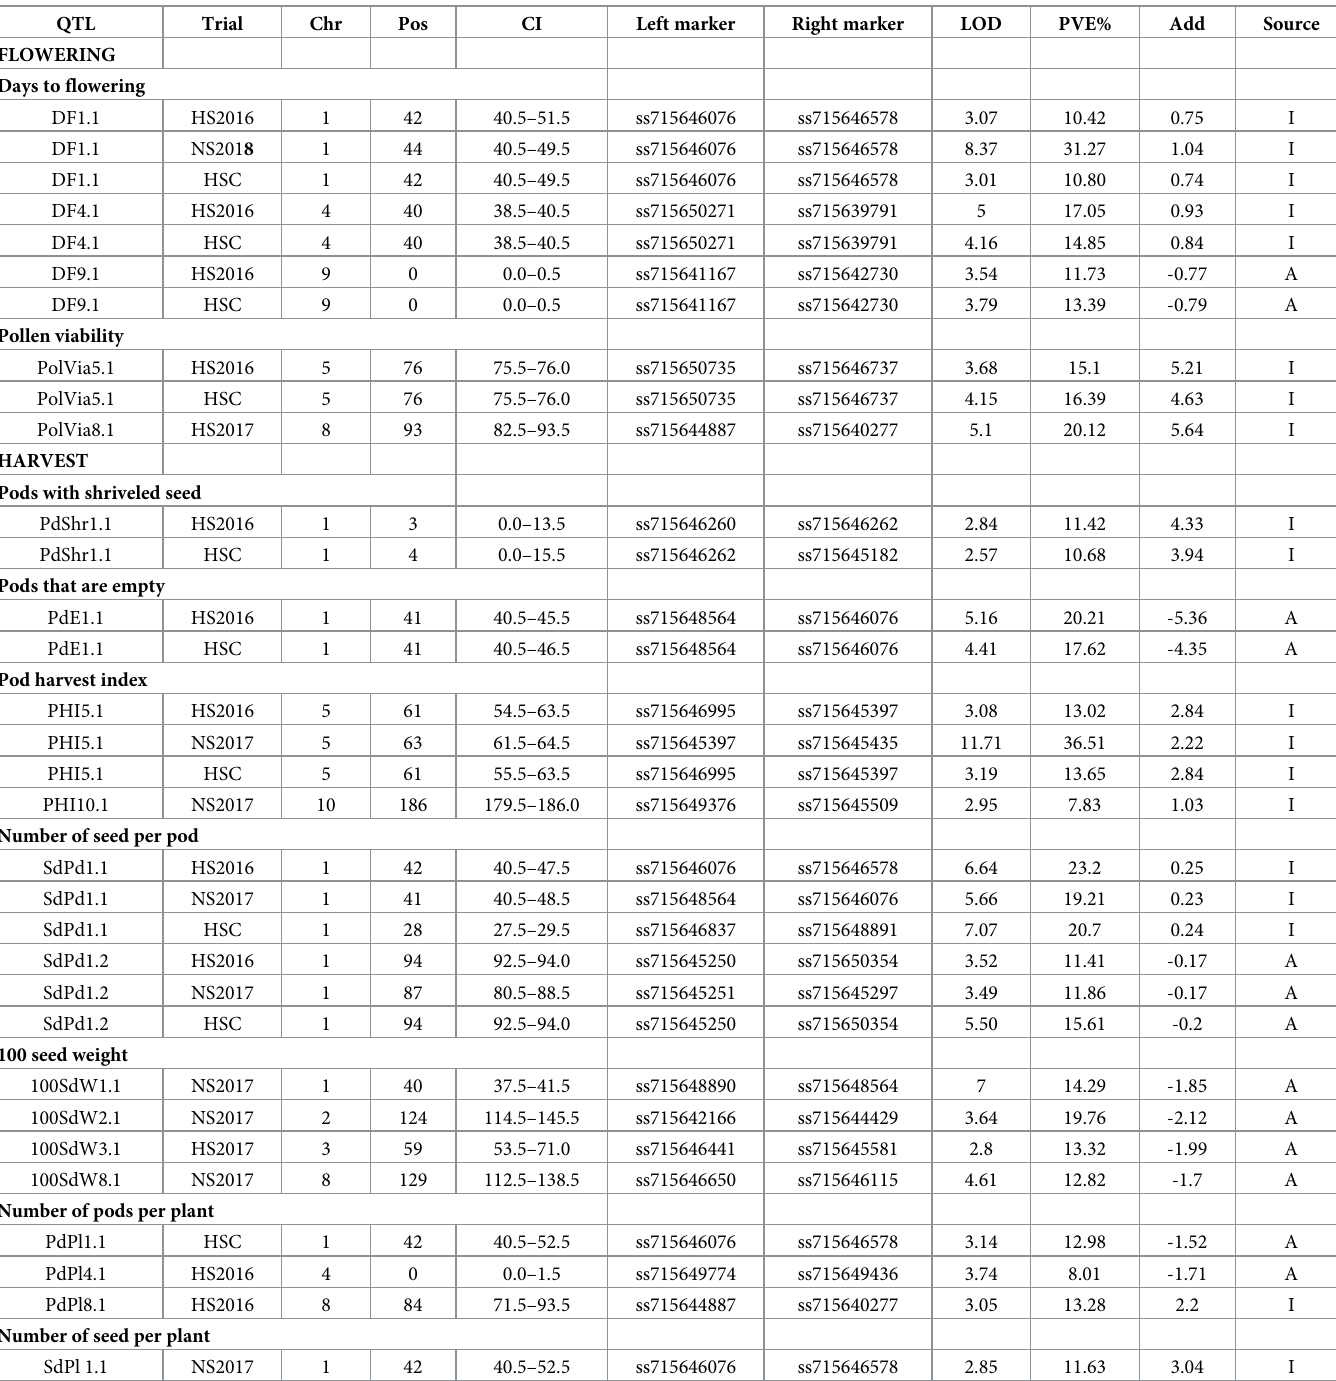
Table 3. QTLs identified in the IJR x AFR298 population evaluated under heat stress (HS) and non-stress (NS)